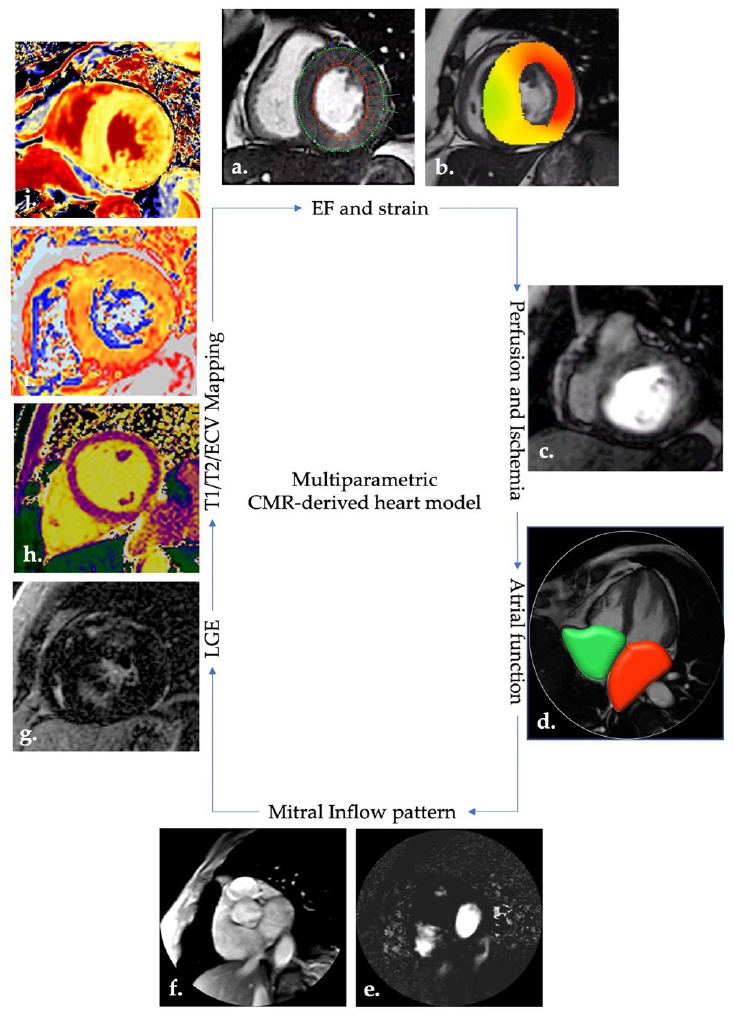
Figure 2. CMR heart model using different imaging biomarkers. Images ( a – j ) show different examples of CMR biomarkers useful in a proper definition of a HF patient. Images ( a , b ) show cine images; in image ( a ): endocardial (red) and epicardial (green) contours are drawn in all SA stacks, both in diastole and systole through a dedicated software; endocardial and epicardial contouring are used to estimate ventricular volumes and myocardial mass, respectively. In image ( b ): an example of radial strain depicted by a colorimetric map superimposed on an SA cine image; colorimetric map shows the degree of myocardial deformation evaluated by the strain analysis. Bright colors suggest a lower deformation. Image ( c ) shows an example of first-pass perfusion imaging: the wide hypointense rhyme within the inferior wall represent a region of myocardial ischemia. Image ( d ), atrial evaluation: atrial volumes allow dimension and function to be estimated: left and right atria are showed in the figure through red and green reconstruction in systole (LA and RA maximum volume). Images ( e ) (phase image) and ( f ) (magnitude image) show an example of phase-contrast sequence for the evaluation of valvular flow. Images ( g – j ) show the sequence currently adopted for proper tissue characterization. In image ( g ), the post-contrast LGE sequence shows a faded enhancement within hypertrophic segments in an HCM patient. Images ( h – j ) show mapping sequences. In image ( h ), regular naïve (pre-contrast) T1 mapping in a young athlete. In image ( i ), abnormal T2 mapping (high values) in non-treated AL amyloidosis. In image ( j ), abnormal ECV sequence (high values in lateral wall) in Anderson–Fabry disease. CMR: cardiac magnetic resonance; HF: heart failure; SA: short axis; LA: left atrium; RA: right atrium; LGE: late gadolinium enhancement; HCM: hypertrophic cardiomyopathy; AL: amyloid light chain; ECV: extracellular volume.